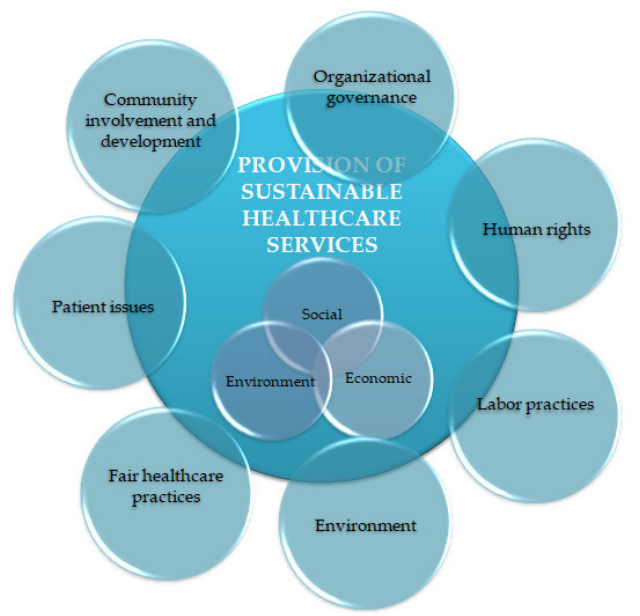
Figure 2. The pillars of sustainable development and the social responsibility core topics according to ISO 26000.